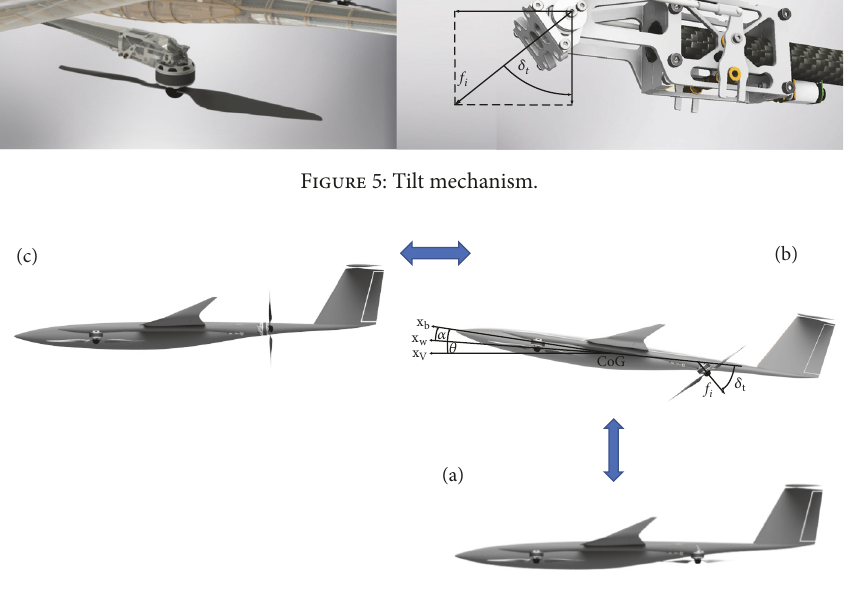
Figure 6: The flight envelope: (a) VTOL mode, (b) transition mode, and (c) aircraft